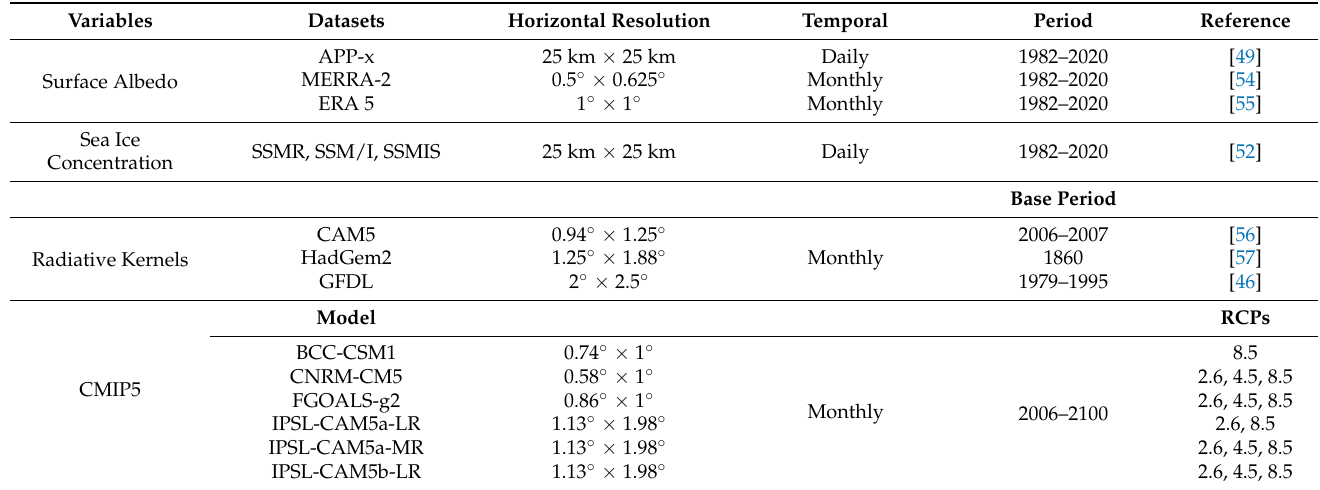
Table 1. Description of the datasets used in this